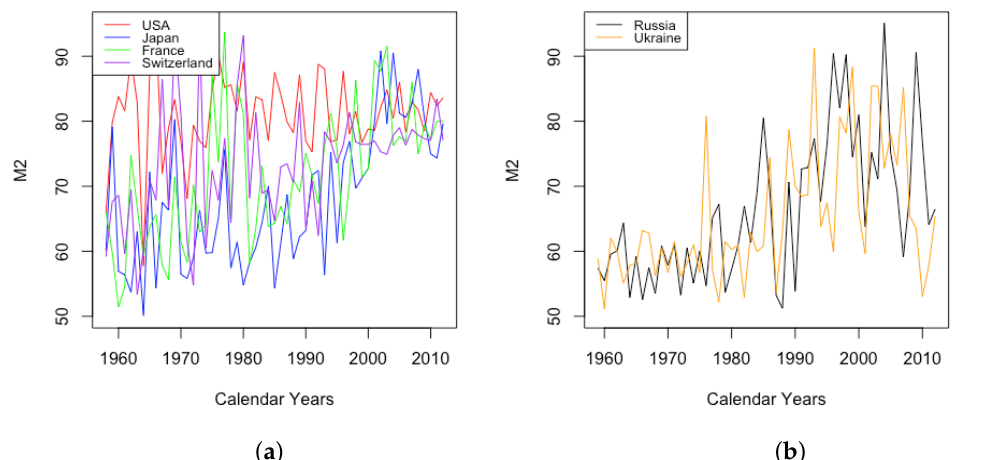
Figure 11. ( a ) The age of fastest growth of the mortality acceleration factor across HLE countries. ( b ) The age of fastest growth of the mortality acceleration factor across ILE countries.